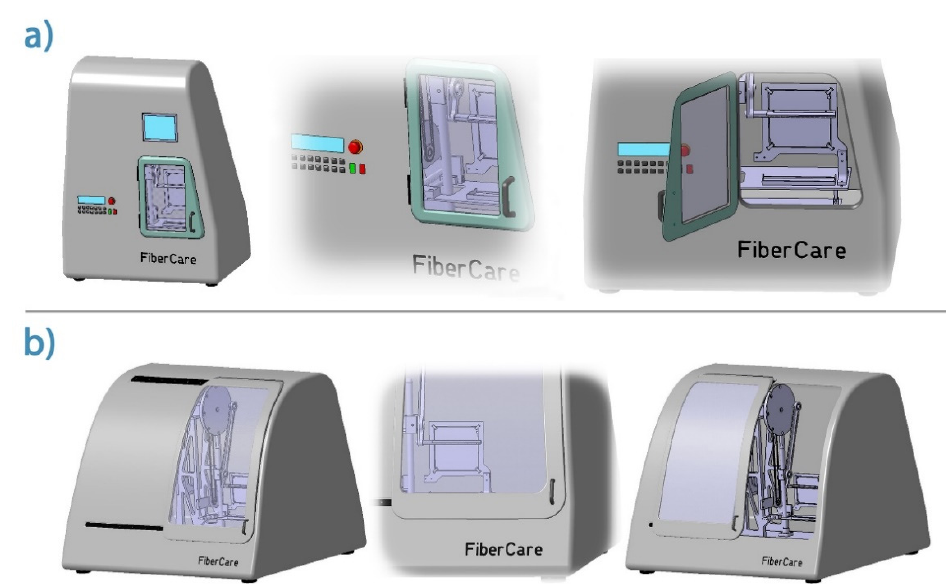
Figure 5. Three-dimensional views of various visual designs (( a ) outer views with controlling elements, ( b ) inner views) of future ’ready for clinical use’ contact drawing device (FiberCare).